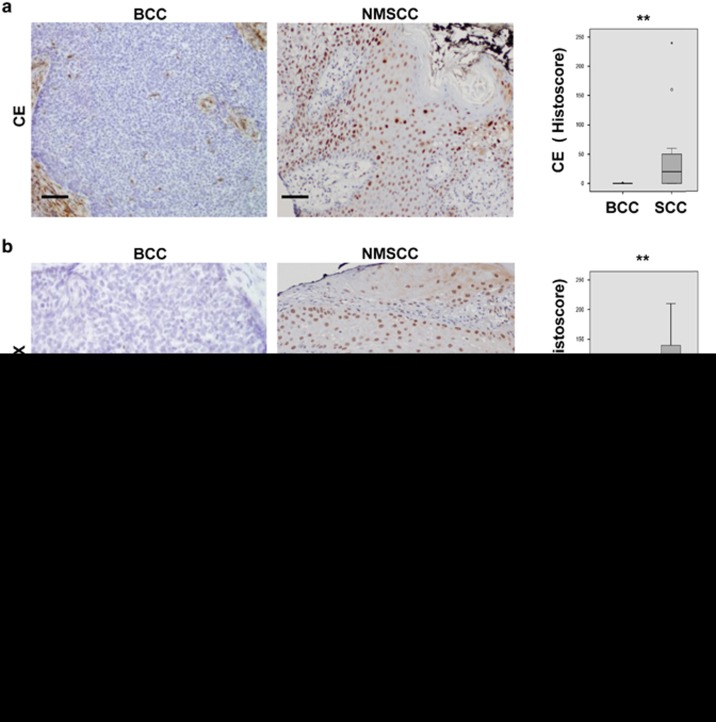
The axis Cyclin E/γH2AX is high in human NMSCCs, low in BCCs and MSCCs. (a,b) Microphotographs show representative images of immunohistochemical (IHC) staining of BCC or non-metastatic SCC (NMSCC) biopsies for (a) Cyclin E (CE) or (b) γH2AX. See also Supplementary Figures 2a,b. Histograms show histoscore values for CE (a) or γH2AX (b) in the series of BCCs (n=15) and SCCs (n=35). Scale bars, 200 μm. (c) Left histogram: histoscore values for CE in NMSSC (n=17) and metastatic SCC (MSCC; n=18). Right: bar histogram shows percent of cases displaying nuclear or cytoplasmic localisation of CE (nuclear or cytoplasmic) within NMSCCs (light grey) or MSCCs (dark grey). See also Supplementary Figure 2b. (d) Histoscore values of γH2AX in NMSCC and MSCC (left) or in SCC well differentiated (Diff; n=10), moderately differentiated (Mod; n=20) and poorly differentiated (Poor; n=5) (right; see also Supplementary Figure 2a). Data plotted by tests Kruskal-Wallis/Mann-Whitney U. *P<0.05 and **P<0.01